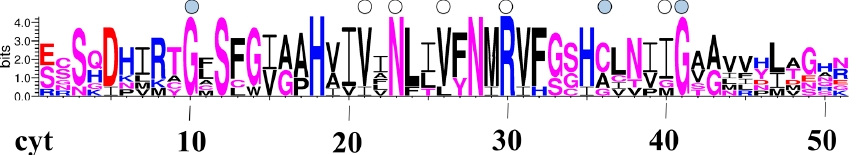
Figure 2. Pore logo representation of human AQPs. Sequence logo of the pore-lining residues for the seven human orthodox AQPs. The logo numbers correspond to the structural position of the residues along the channel axis and not to their sequence position. Each pore is orientated from the intracellular (left) to the extracellular (right) side. Acidic residues are coloured in red, basic residues in blue, hydrophobic residues in black and polar residues in purple. The pore positions where mutations occur, which are hypothesized to affect the pore features herein or in previous studies [21,25], are pointed out by a filled or an empty circle, respectively.